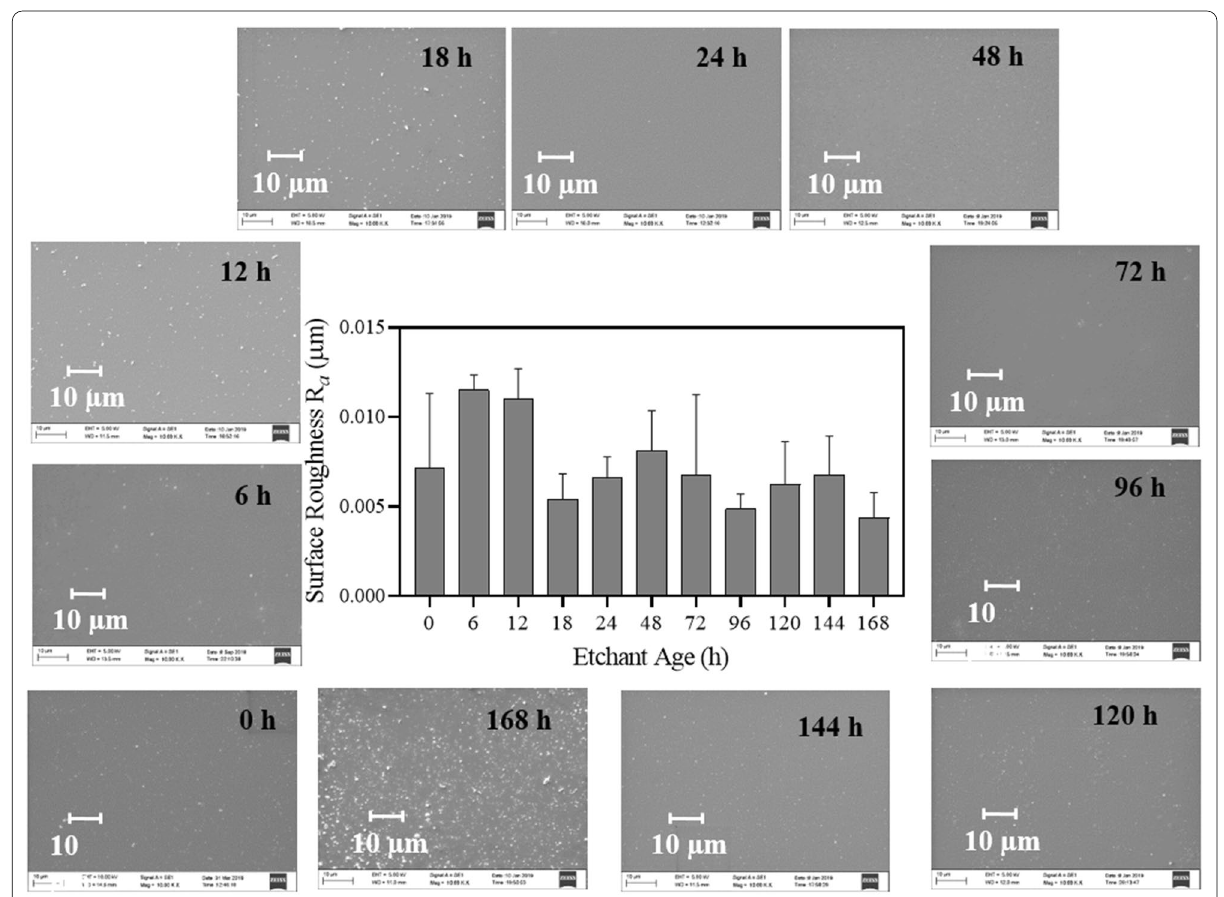
Fig. 50 Surface roughness (Ra) and corresponding surface morphologies of Si{111} with aging time of 15% NH 2 OH-added 20 wt% KOH